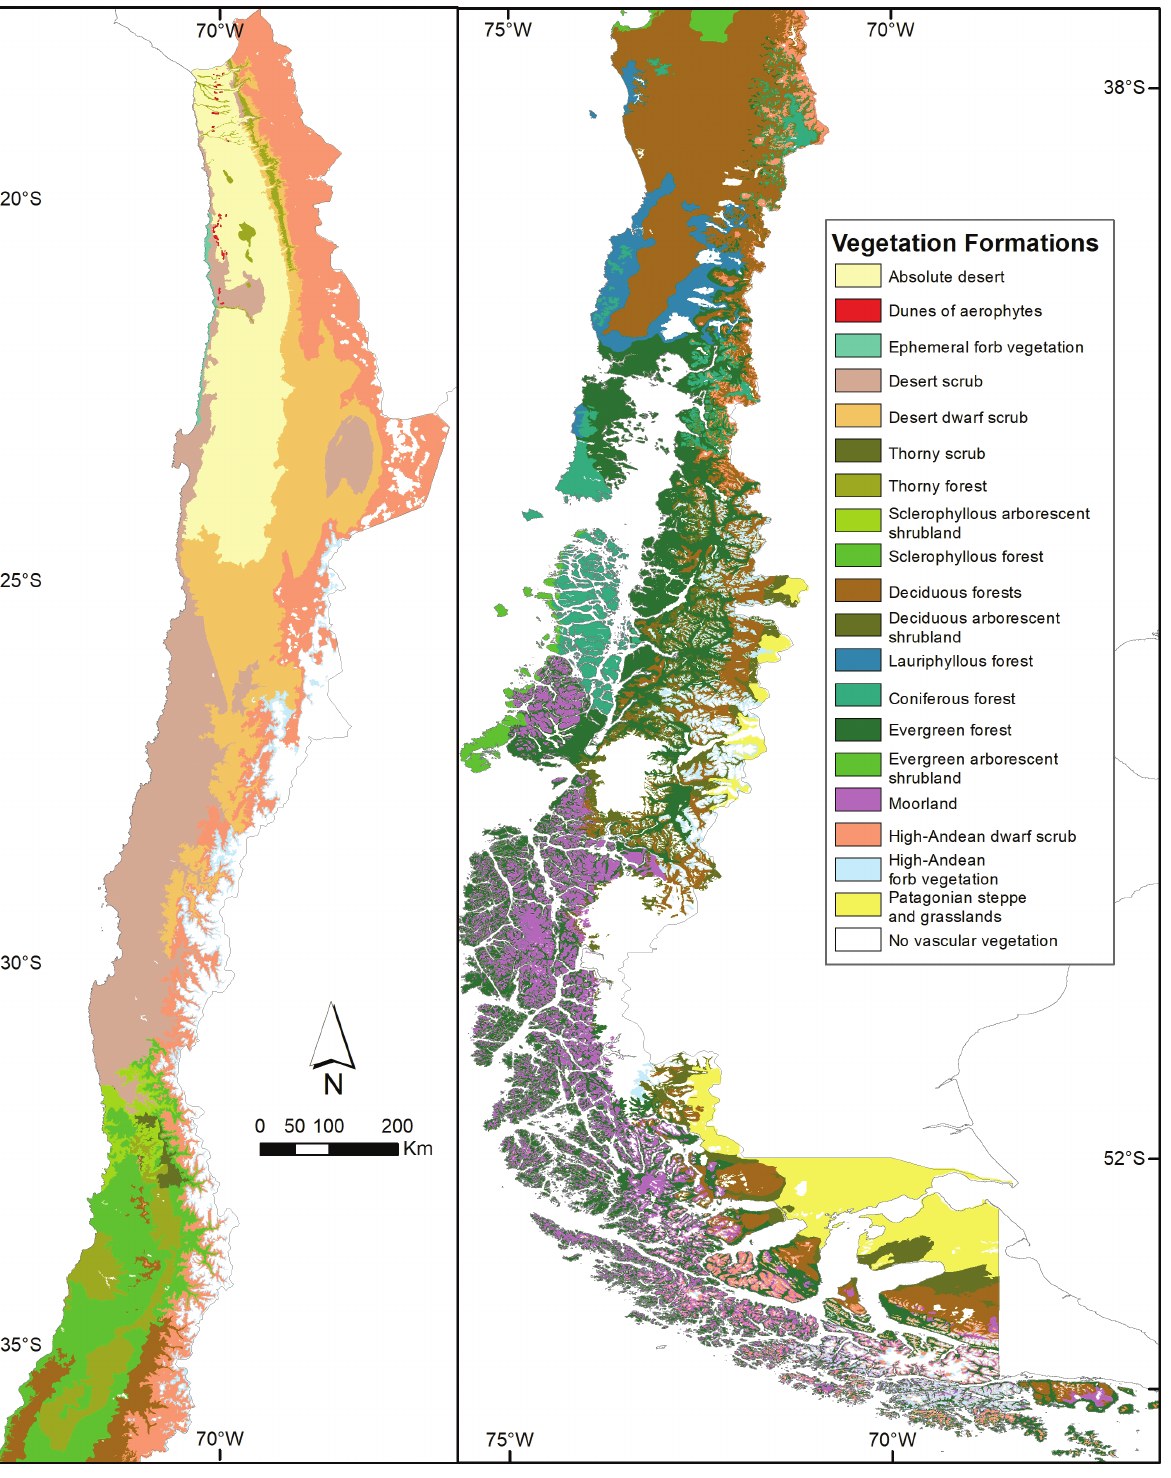
Figure A2. Map of Chilean formations of zonal vegetation as defined in Luebert and Pliscoff (2017). This map is available as shapefile at the Zenodo repository